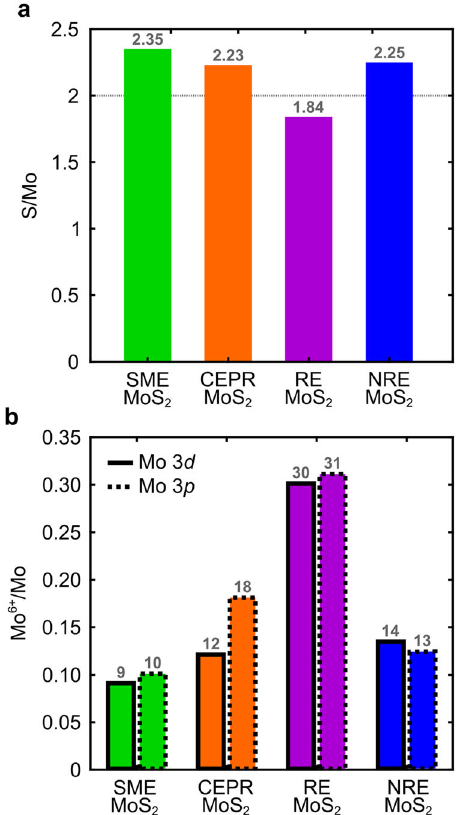
Fig. 5 XPS analysis of the exfoliation procedure-dependent MoS 2 thin fi lms. a The S/Mo ratios from the Mo 3 p and S 2 p fi tted peaks, where stoichiometric and the bulk CVT MoS 2 are noted with S/Mo = 2 (horizontal dashed line) and 2.54, respectively. b The Mo 6 + /Mo atomic percentage from Mo 3 d and S 2 s fi tted peaks (solid outline) and from the Mo 3 p and S 2 p fi tted peaks (dashed